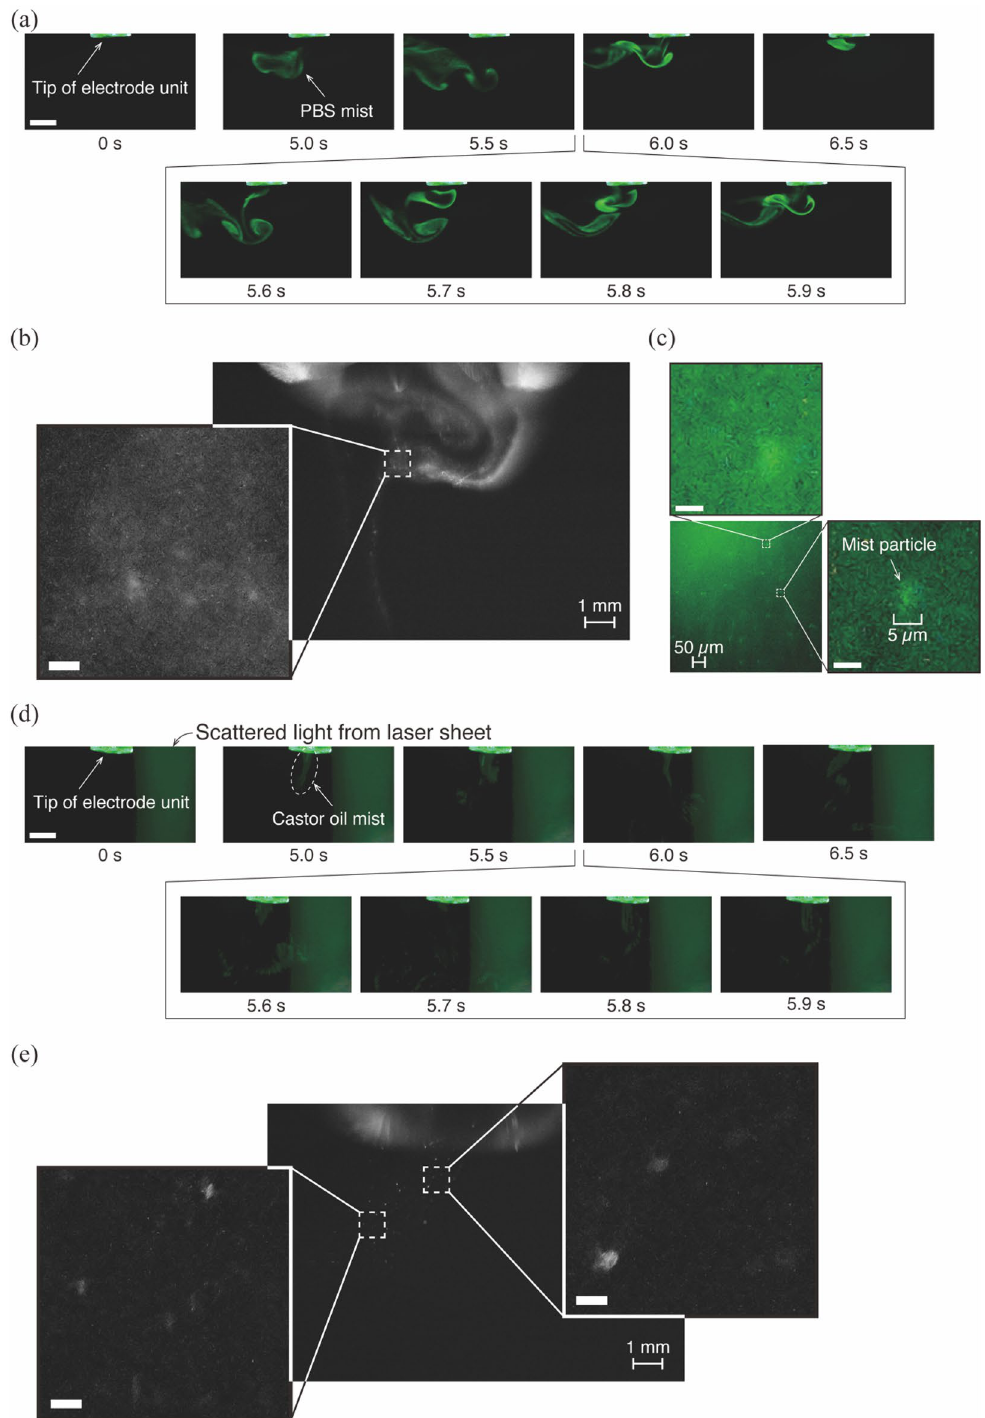
Figure 4. Nano-sized mist generated from each solution. Time-sequential images of the mist captured with a macro lens, visualized at 240 fps. The infusion rate of ( a ) PBS or ( d ) castor oil was 50 µL/min. These images were obtained from Supplementary Movies 3 and 4. Scale bar, 5 mm. Gamma correction is applied to the image ( d ) because the castor oil mist particles are too fine to be seen. Magnified images of the mist generated from ( b ) PBS or ( e ) castor oil, taken with the 10 × microscope lens. Scale bars, 100 µm. ( c ) Magnified high-speed images of the PBS mist taken with the 100 × microscope lens. Scale bars, 5 µm. These images show a single frame taken at a shutter speed of 1/8000 s and an ISO sensitivity of